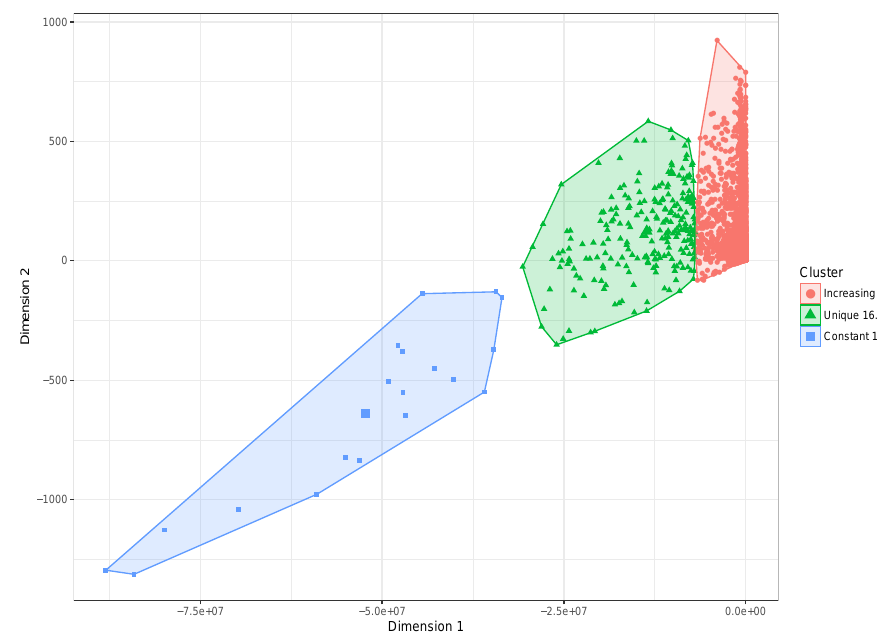
Figure 7. Segment classification with logistic regression by